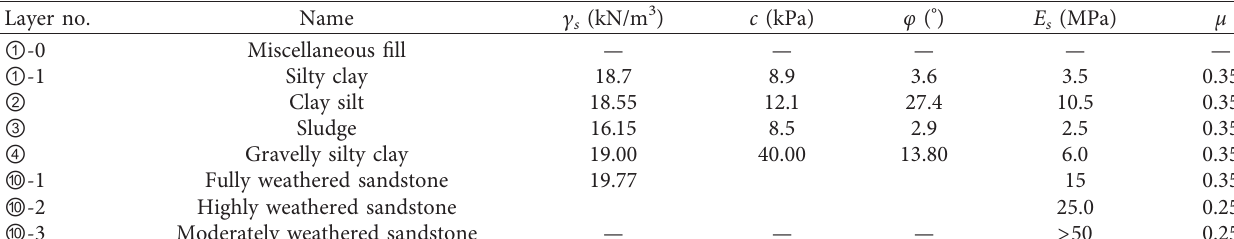
Figure 1: Overall arrangement of No. 3 section basement construction project of Ganshuixiang (unit: m). Note: 1–5 represent Nos. 1–5 sections of Table 1: Physical and mechanical nature of soils.